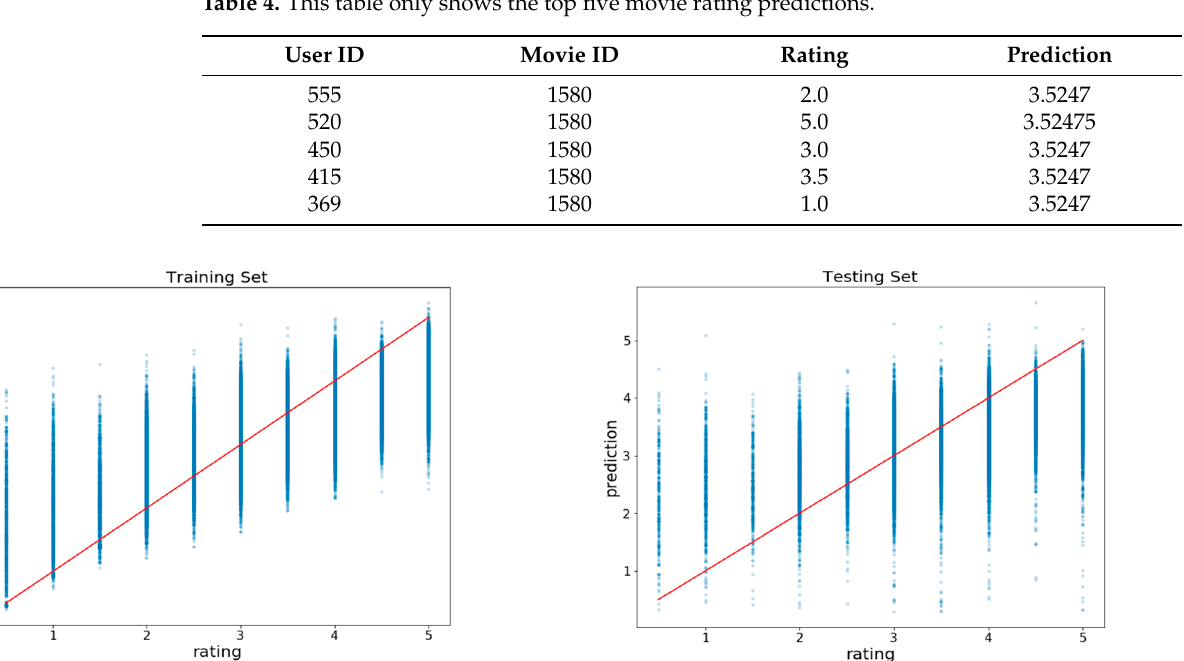
Table 2. Movie lists according to different genres.